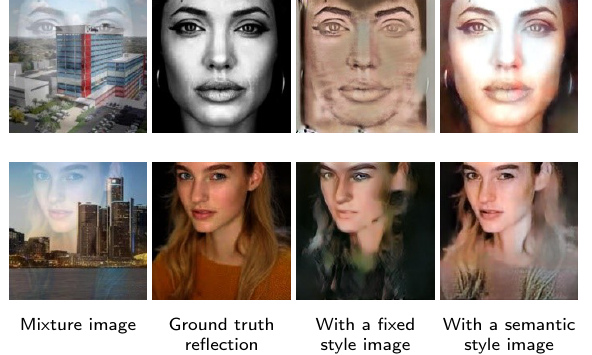
Figure 16. Comparisons of visual effects of the proposed network with a fixed style image or with a semantic style image. The top and bottom rows correspond to dim and vivid reflection images with